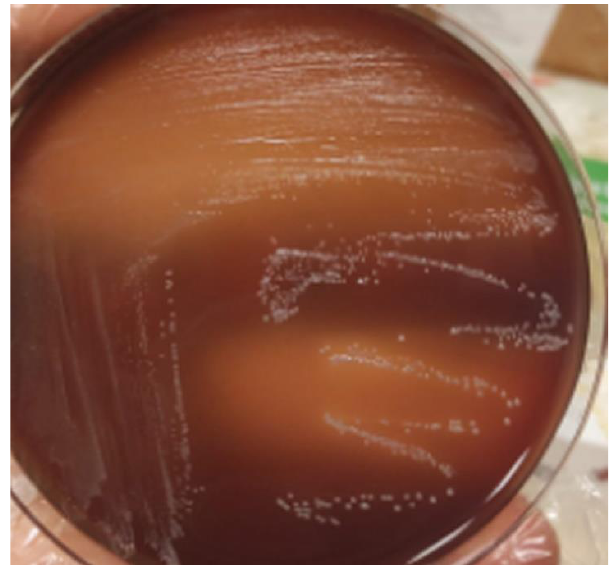
Figure 1 : Brucella growth on the chocolate agar